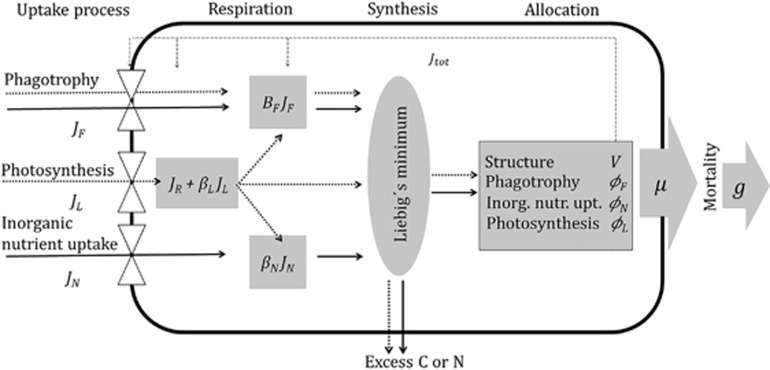
Schematic representation of the model showing how fluxes of carbon (dotted) and nitrogen (solid) are lost through respiration (small gray rectangles), and combined (gray ellipse) to traits and structure (large gray rectangle). Traits, structure and food are assumed to have the same carbon/nitrogen ratio. White triangle symbols represent the functional responses for the uptake mechanisms. Phagotrophy and inorganic nutrient uptake activity depends on energy from sunlight. JR includes the basal respiratory costs of synthesis and maintenance of all traits and structure, and is paid before the uptake of food and inorganic nutrients. Uptake and mobilization for synthesis (or fluxes Ji's) need to pay a respiratory cost represented by a fraction of the gross flux of each pathway. The ellipse represents synthesis of biomass from the available carbon and nutrients following Liebig's law of the minimum and constrained by the Redfield ratio (gC/gN=5.7). In our steady state consideration, a proportion of the assimilated carbon or nutrients are assumed lost as excess resources. Long dashed thin arrows illustrate how resource allocation into traits and structure regulates uptake affinities and respiratory costs.